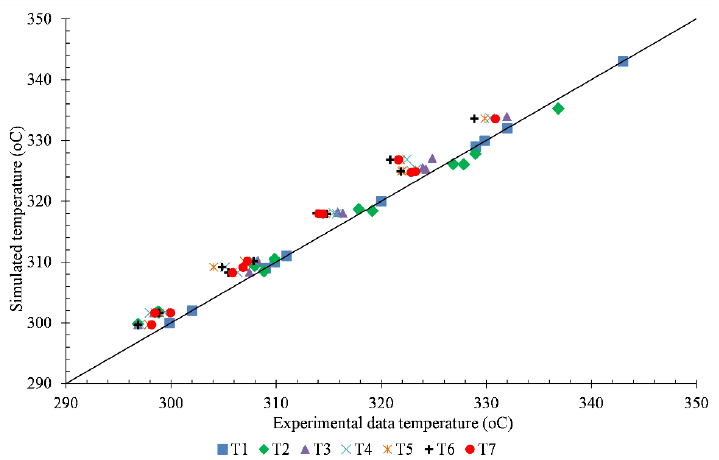
Figure 6. The simulated temperatures and experimental temperatures at 7 points (0, 38, 88, 138, 188, 238, and 288 mm from top of the catalyst bed).